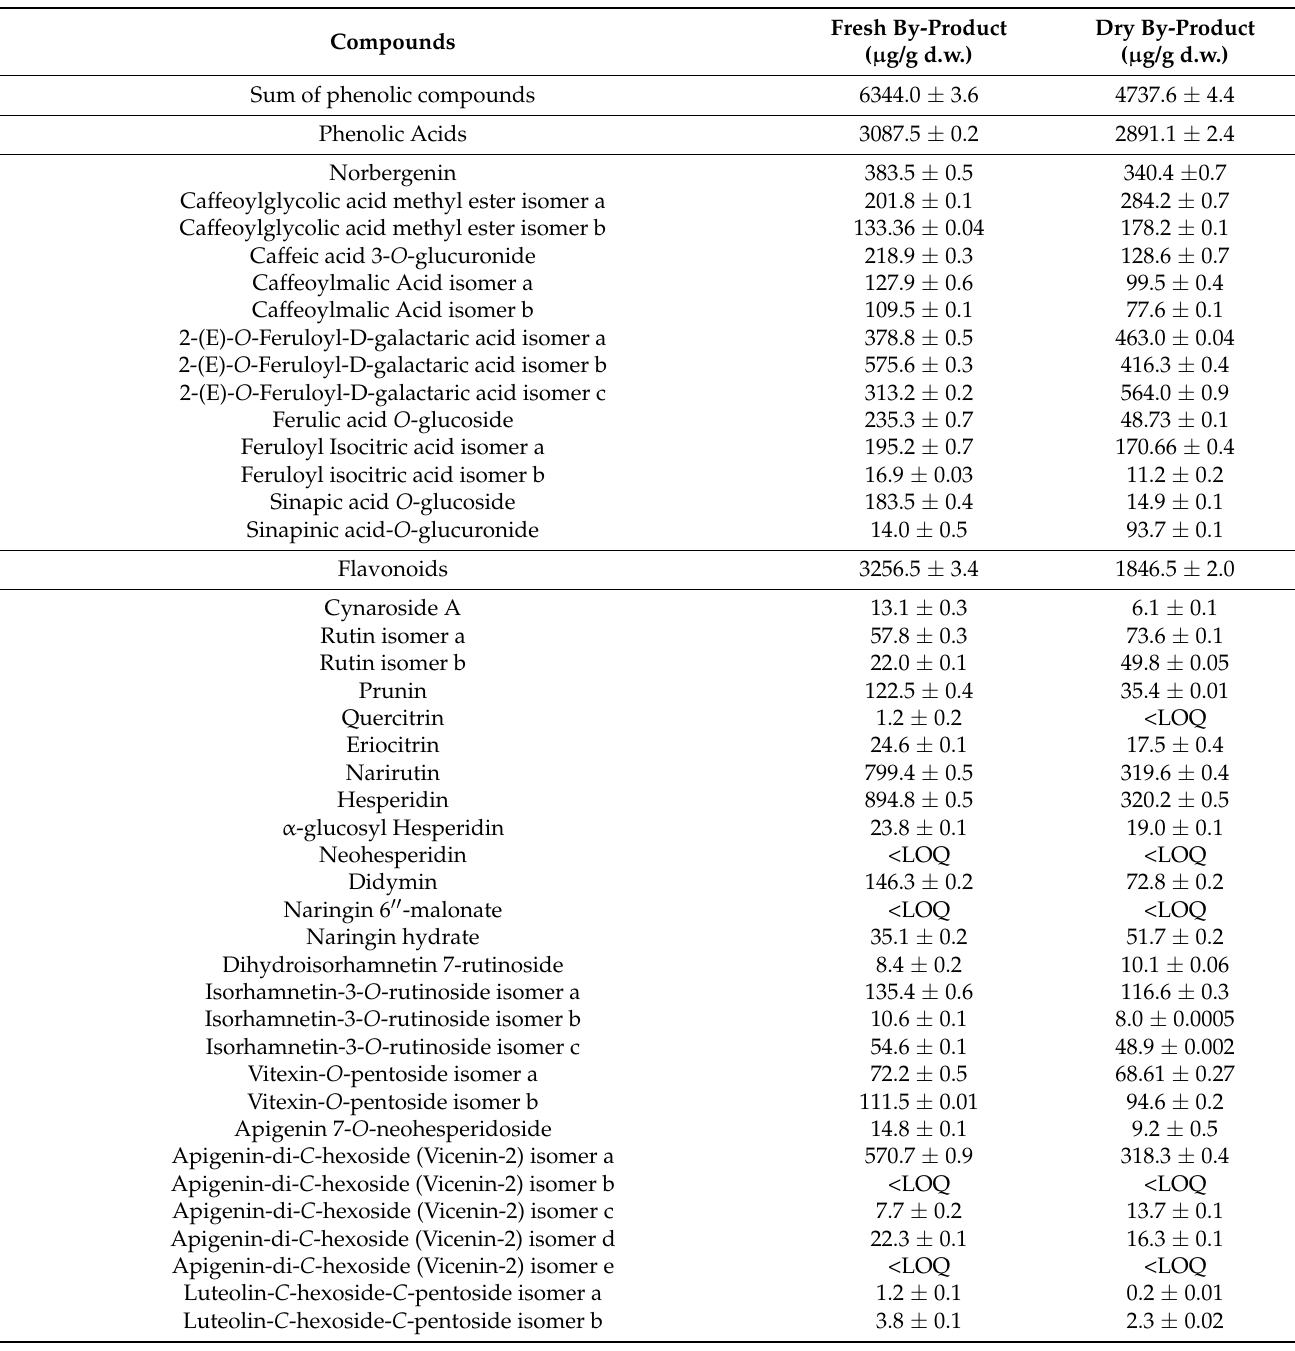
Table 7. Quantification of phenolic compounds from orange peel dry and fresh by HPLC-MS (expressed as mean ± standard deviation µ g/g